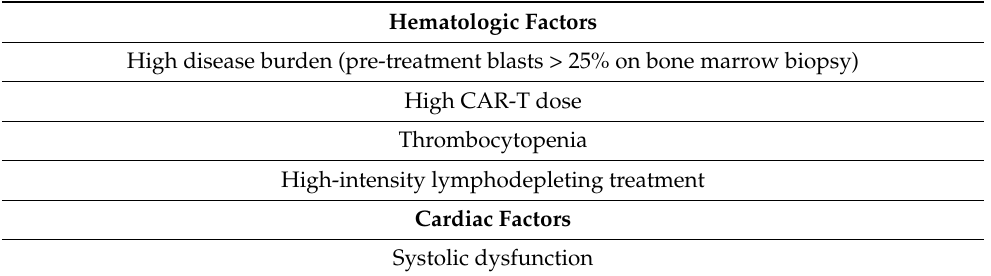
Table 4. Pre-treatment factors associated with cardiotoxicity during CAR-T